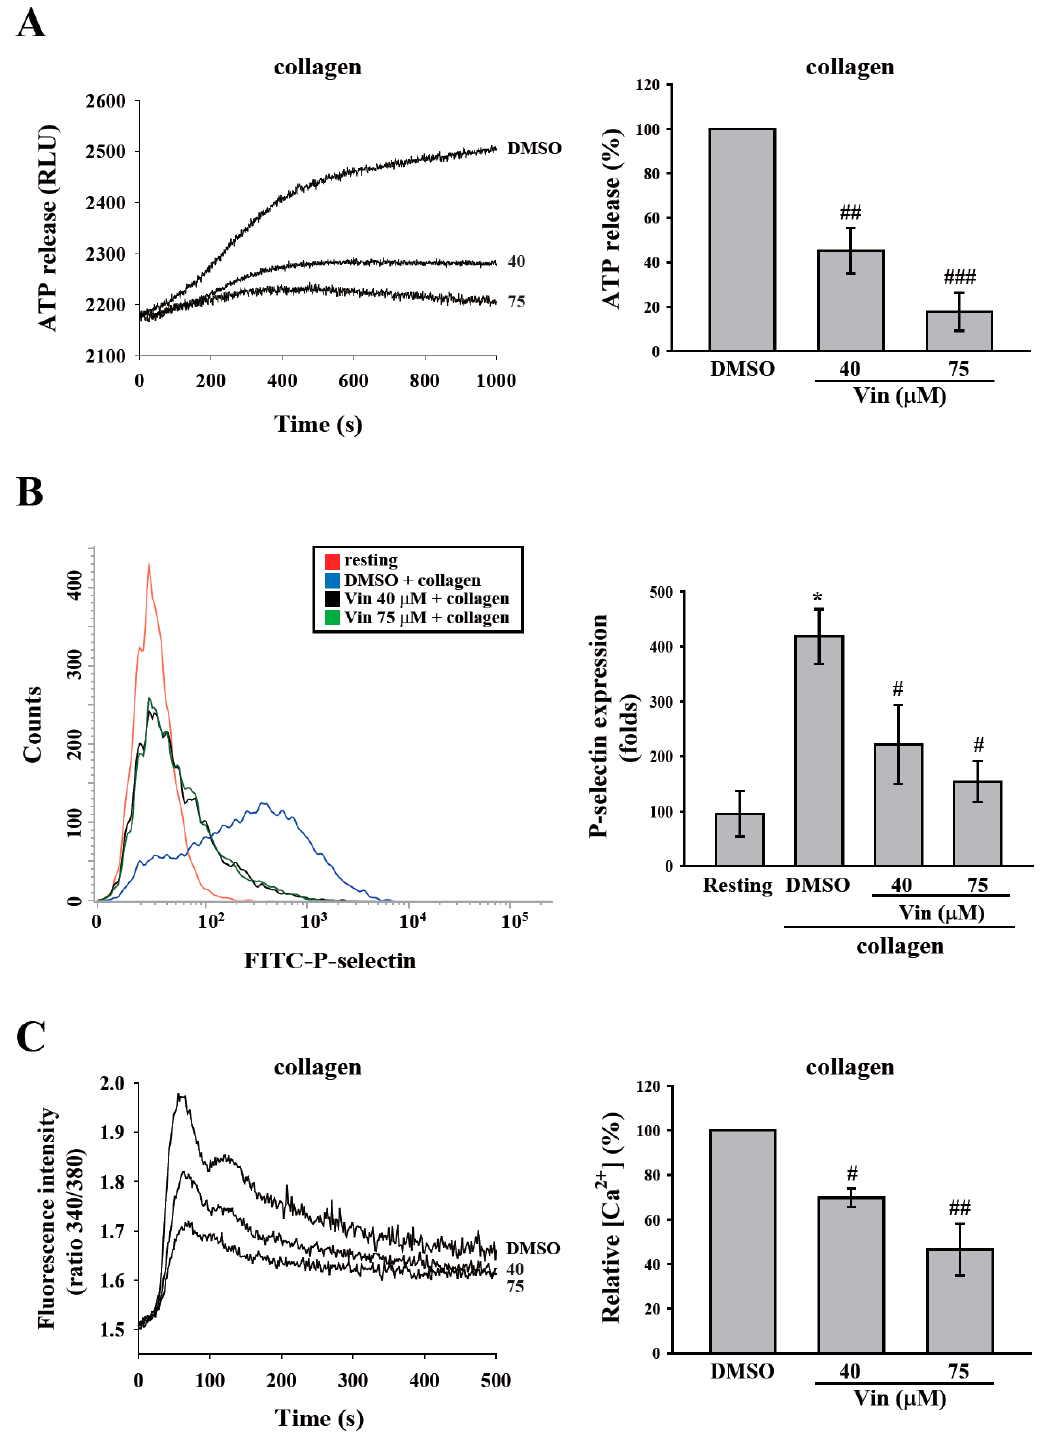
Figure 3. Effects of vincristine on collagen-induced granule release and calcium mobilization in human platelets. Washed platelets (3.6 × 10 8 cells/mL) were treated with vincristine (40 and 75 μ M) or DMSO and then stimulated with collagen (1 μ g/mL) to trigger the release of ATP ( A ), the surface expression of P-selectin ( B ), and calcium mobilization, which were detected using luciferase/luciferin, FITC-P-selectin antibodies, and Fura-2, respectively. Data in ( A – C ) are presented as means ± standard error of the mean ( n = 3). * P < 0.05 compared with the resting group. # P < 0.05, ## P < 0.01, and ### P < 0.001 compared with the DMSO (solvent control) group.